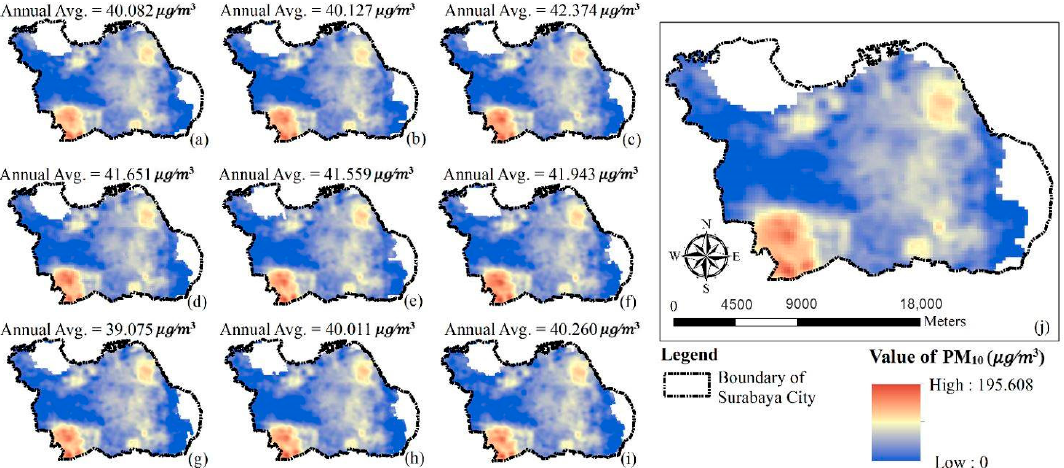
Figure 6. Prediction maps of PM 10 concentration variations using GTWR model: ( a ) 2010 ( b ) 2011 ( c ) 2012 ( d ) 2013 ( e ) 2014 ( f ) 2015 ( g ) 2016 ( h ) 2017 ( i ) 2018 ( j ) average from 2010 to 2018.